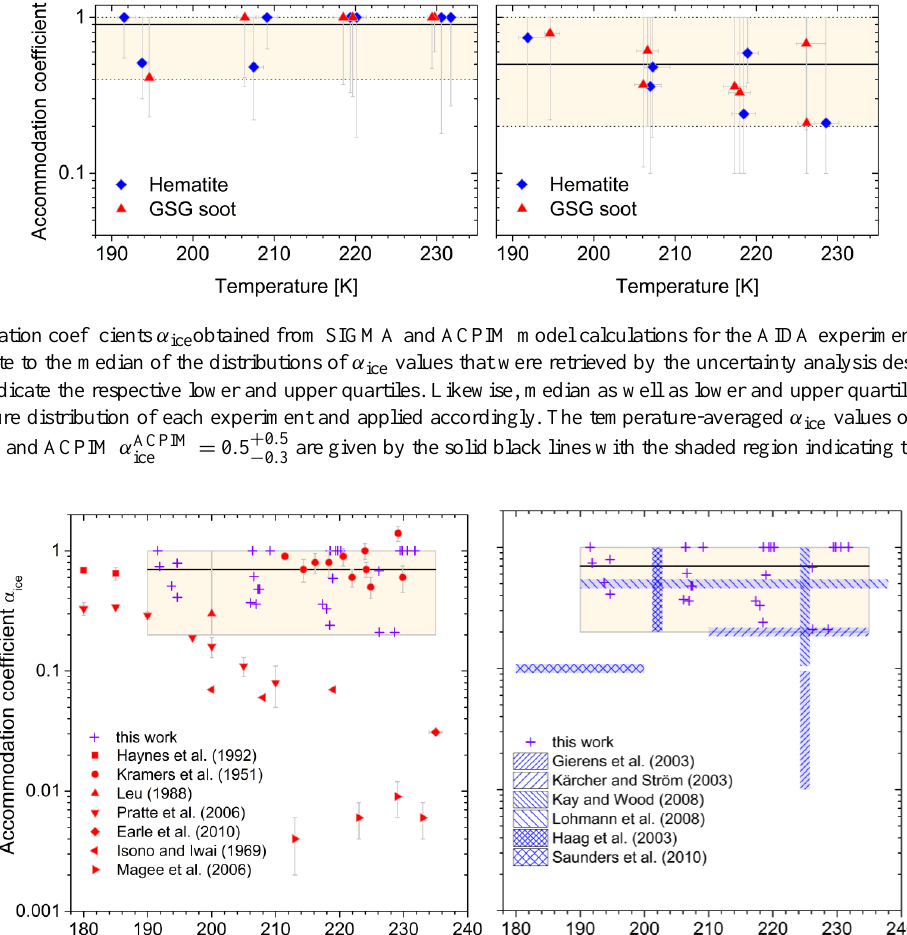
(black solid line, uncertainty illustrated by the shaded region) 0 . 5 0.7    (black solid 3 ice 0.5   values at one temperature or 8 ice